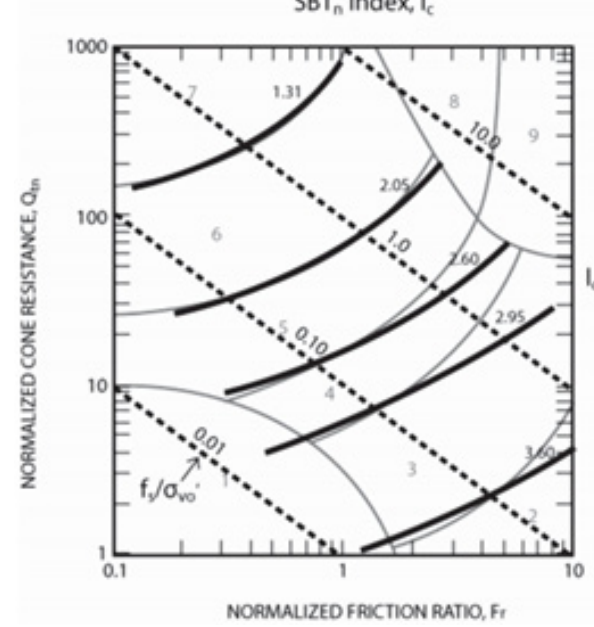
Figure 2: Roberson’s soil behaviour type classification chart [11]